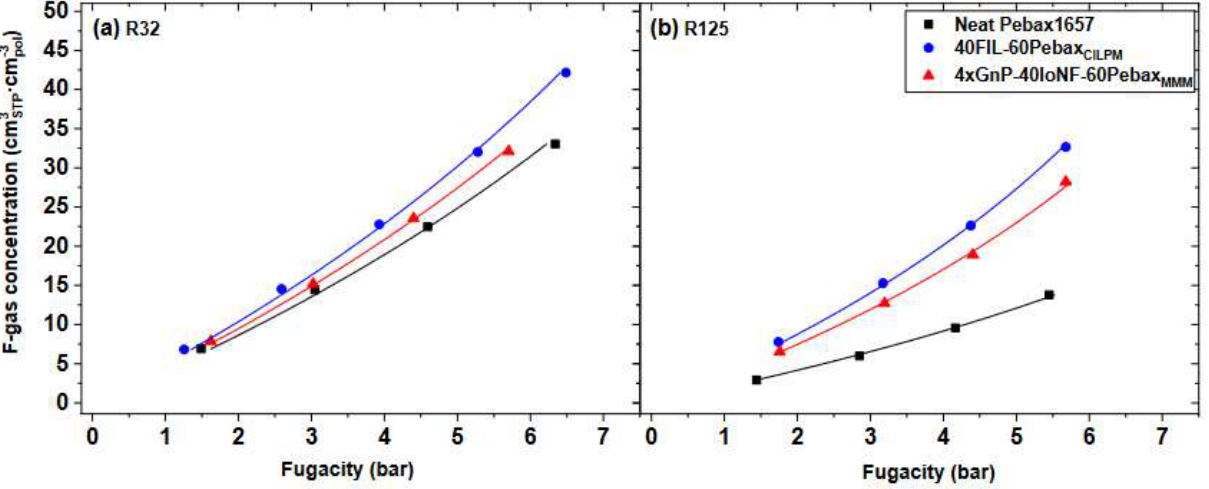
Figure 3. Sorption isotherms of ( a ) R32 (difluoromethane) and ( b ) R125 (pentafluoroethane) at 30 °C in a Pebax membrane and in two mixed-matrix membranes containing ionic liquids. Solid lines correspond to the fit of experimental data to the Flory–Huggins model with varying values of the interaction parameter χ ij . Figure reproduced from [116] under CC-BY license terms.